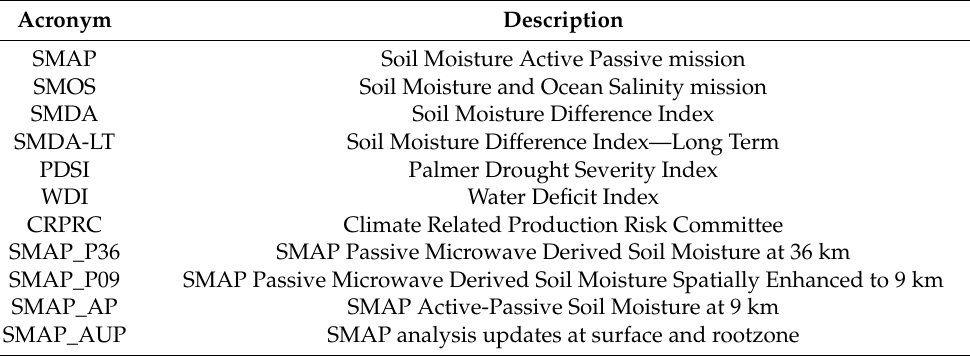
Table 1. Key acronyms used in this manuscript.